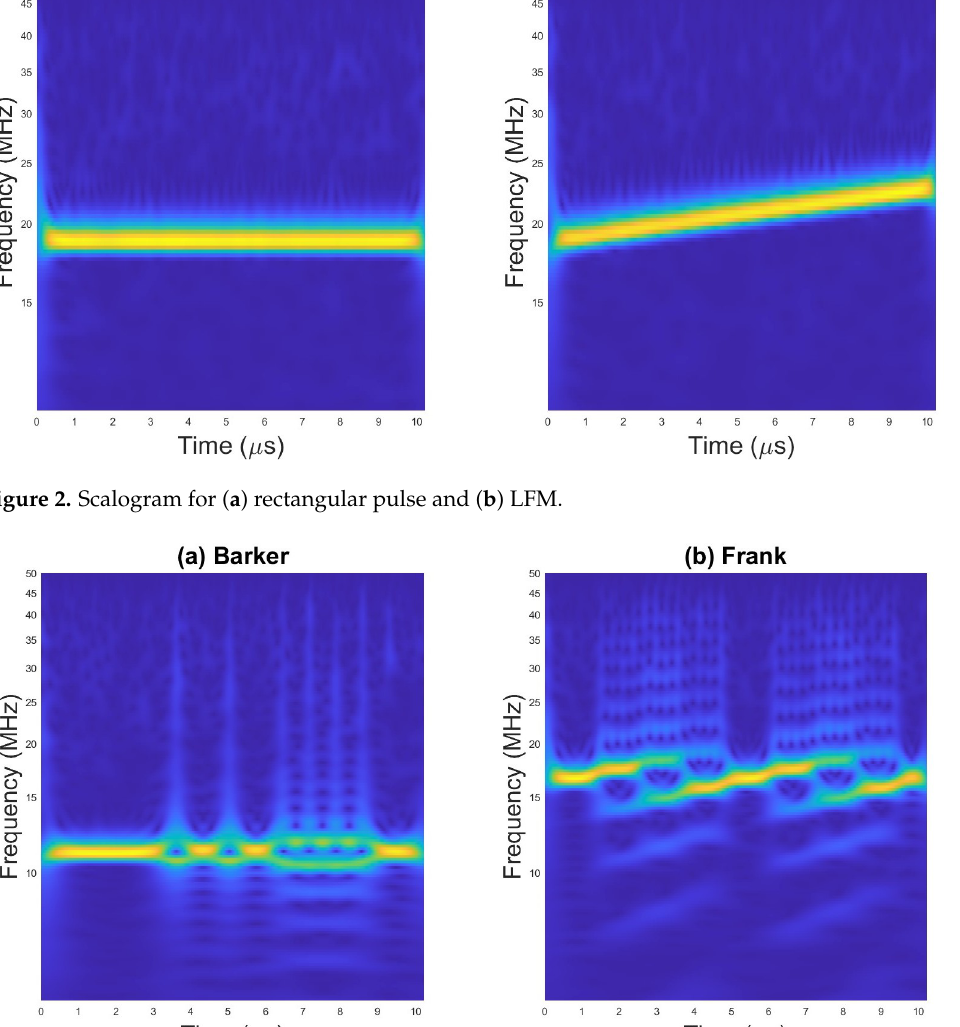
Figure 3. Scalogram for ( a ) pulses with Barker code and ( b ) pulses with Frank